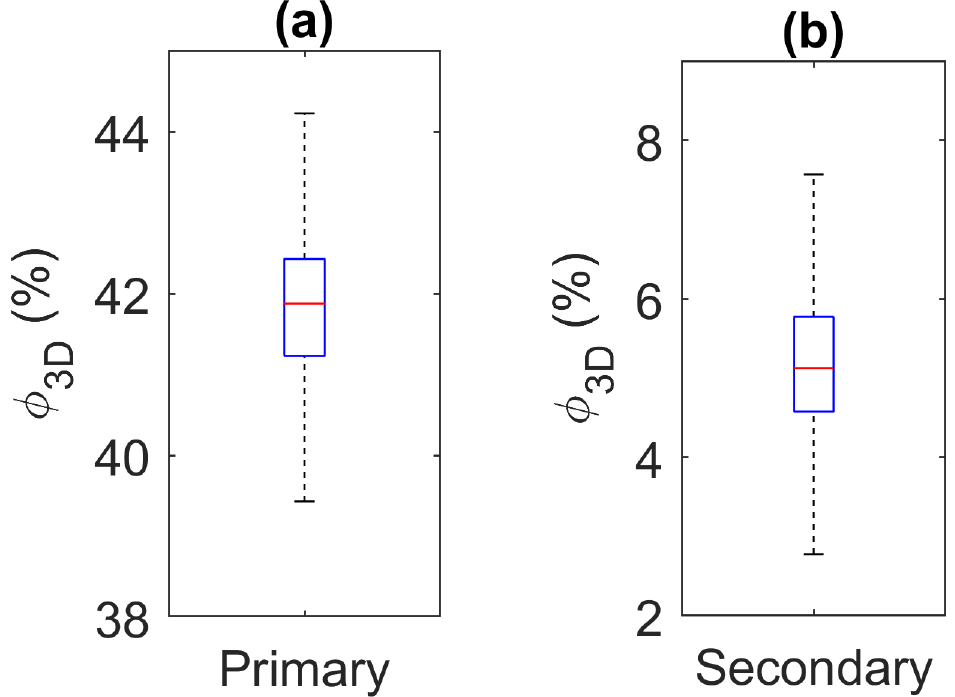
Figure 10. Boxplots show the scatter in the predicted volume fraction of the ( a ) primary and ( b ) secondary particle populations considering a total of 2748 particle